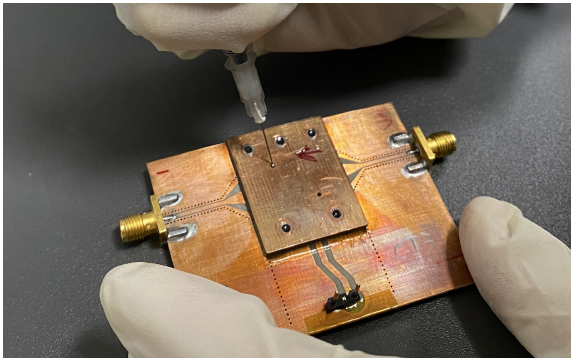
Figure 7. Filling process of one of the cavities of the